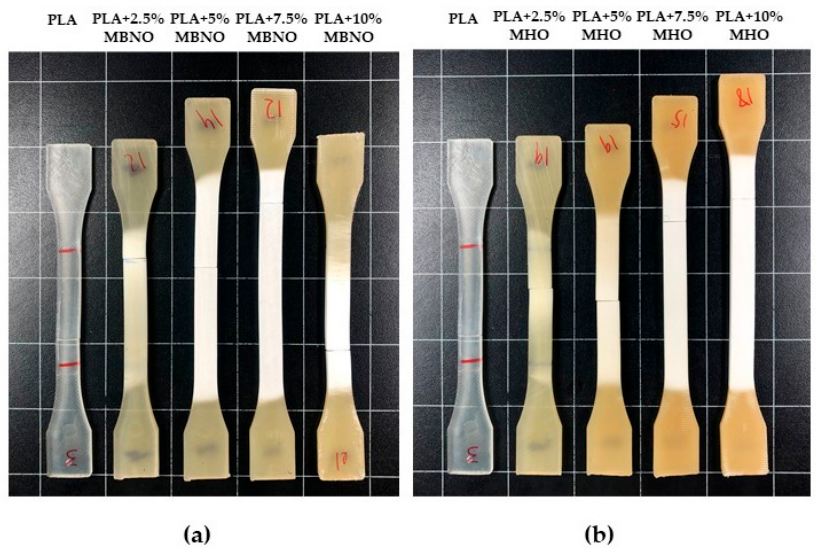
Figure 5. Plot of evolution of tensile properties of PLA formulations plasticized with various contents of MBNO ( a ) and MHO ( b ).